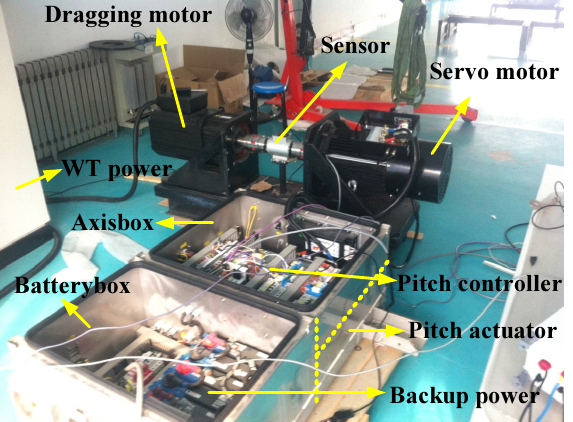
Figure 17. Schematic diagram of the laboratory